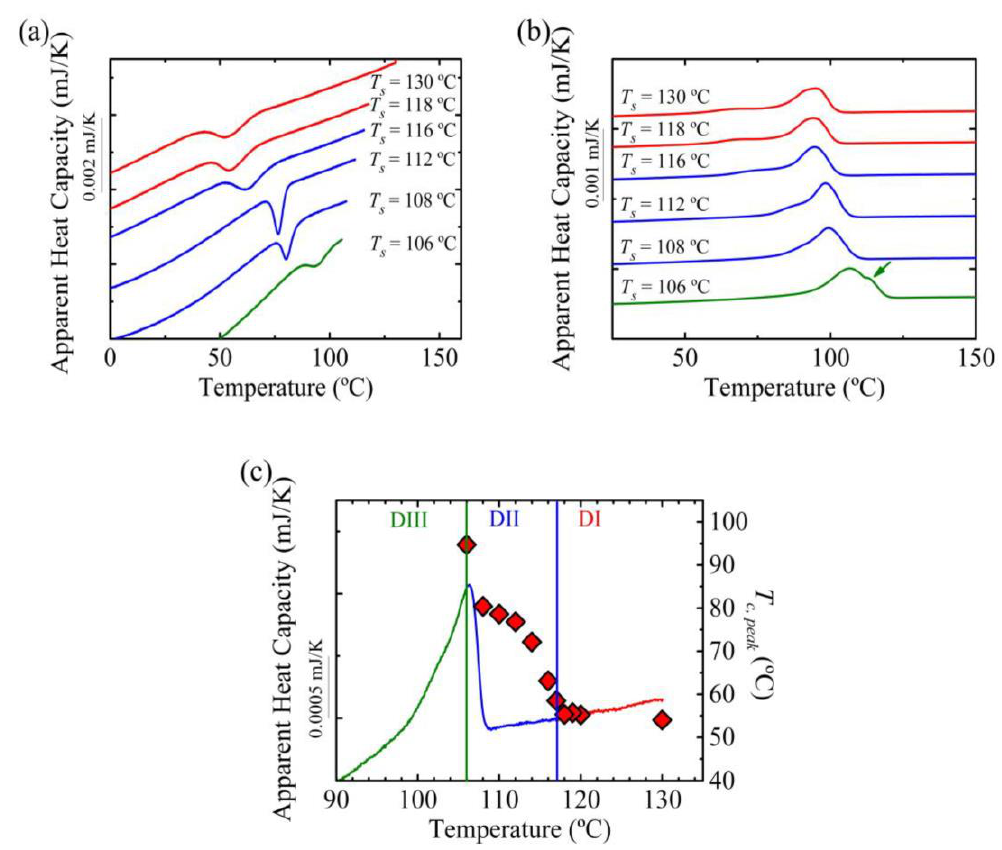
Figure 2. ( a ) Differential scanning calorimeter (DSC) cooling scans of PBS from the indicated self-nucleation temperatures and ( b ) subsequent heating scans. ( c ) Crystallization temperature (right-hand side y-axis) as a function of self-nucleation temperature (x-axis) on top of the PBS DSC heating scan (the DSC heating scan is represented in colors that match the different SN Domains ).